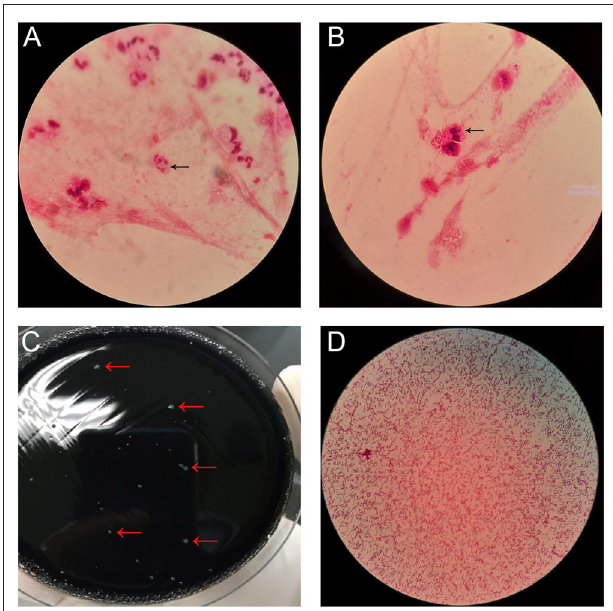
FIGURE 4 | (A,B) Gram stain of bronchoalveolar lavage fluid (BALF) with arrows indicating Legionella pneumophila , magnification × 1,000. (C) L. pneumophila colonies on MWY selective agar (red arrows) from BALF. (D) Gram stain of L. pneumophila colonies (magnification ×